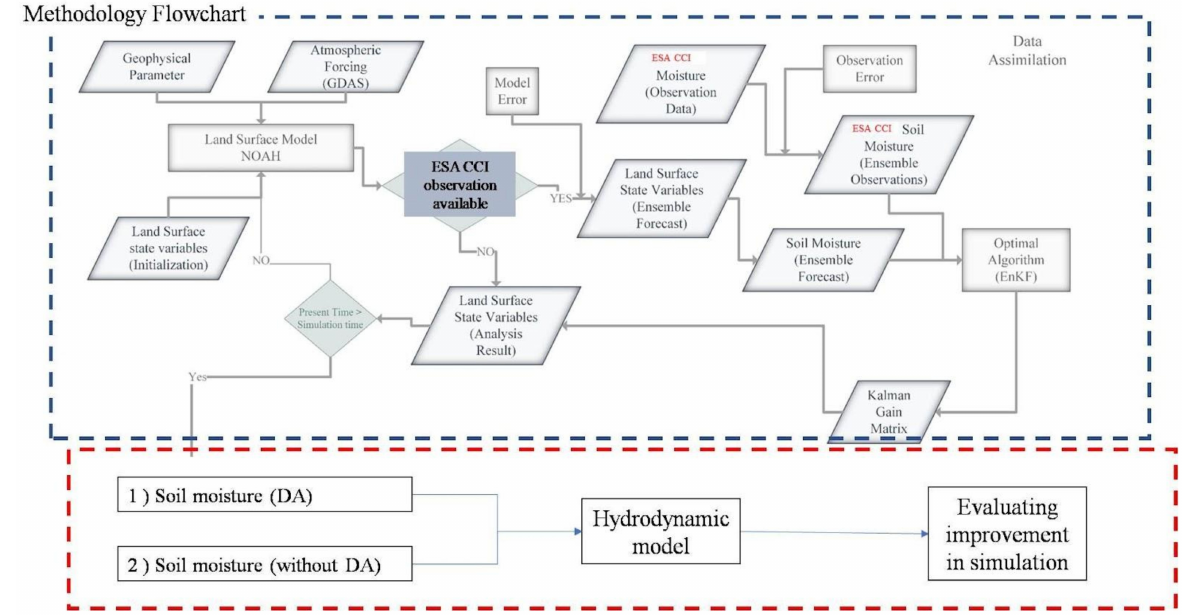
Figure 2. Methodology flowchart showing Stage 1 (Blue box) and Stage 2 (Red box).